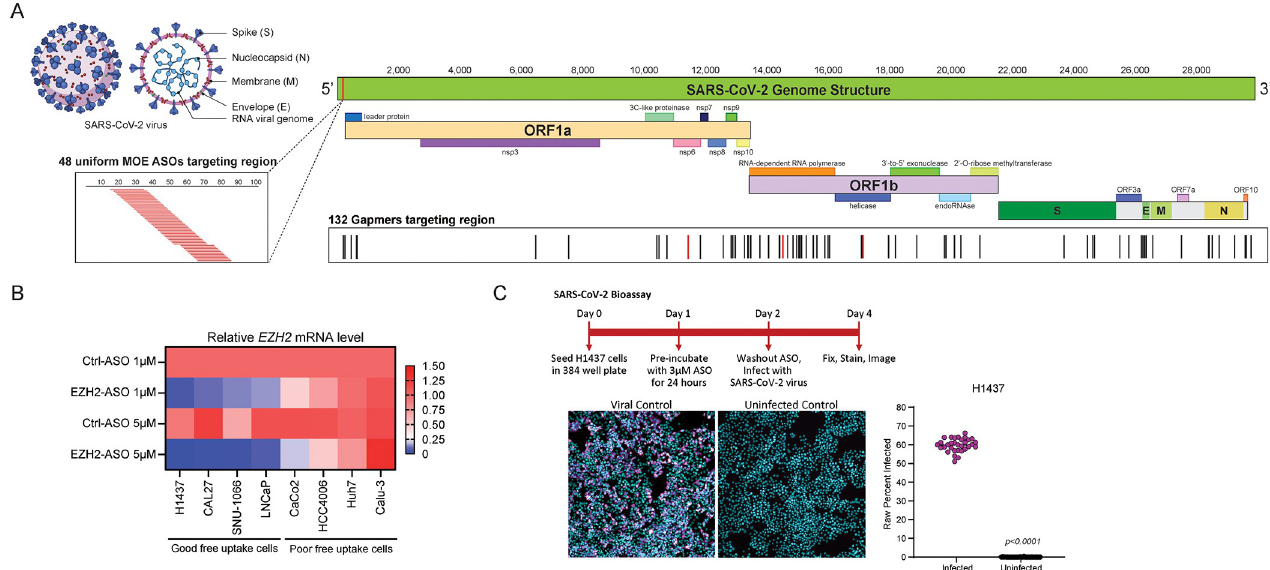
Fig 1. Antisense oligonucleotides (ASOs) designed to target SARS-CoV-2 genome. (A) Top left, SARS-CoV-2 viral structure. Right, SARS-CoV-2 genome structure and location of 48 2’-O-methoxyethyl (2’MOE)-modified uniform ASOs targeting the SARS-CoV-2 5’ untranslated region (UTR) and 132 2´ constrained ethyl (cEt) Gapmer ASOs targeting additional regions. (B) Relative EZH2 mRNA level in indicated cell lines after 1 μ M or 5 μ M of negative control (Ctrl) or EZH2 ASO treatment showing the free uptake ability of various cell lines. (C) Biosafety Level 3 (BSL-3) SARS-CoV-2 bioassay in H1437 cells with washout step and raw infectivity of H1437 cells by SARS-CoV-2 WA1 strain.